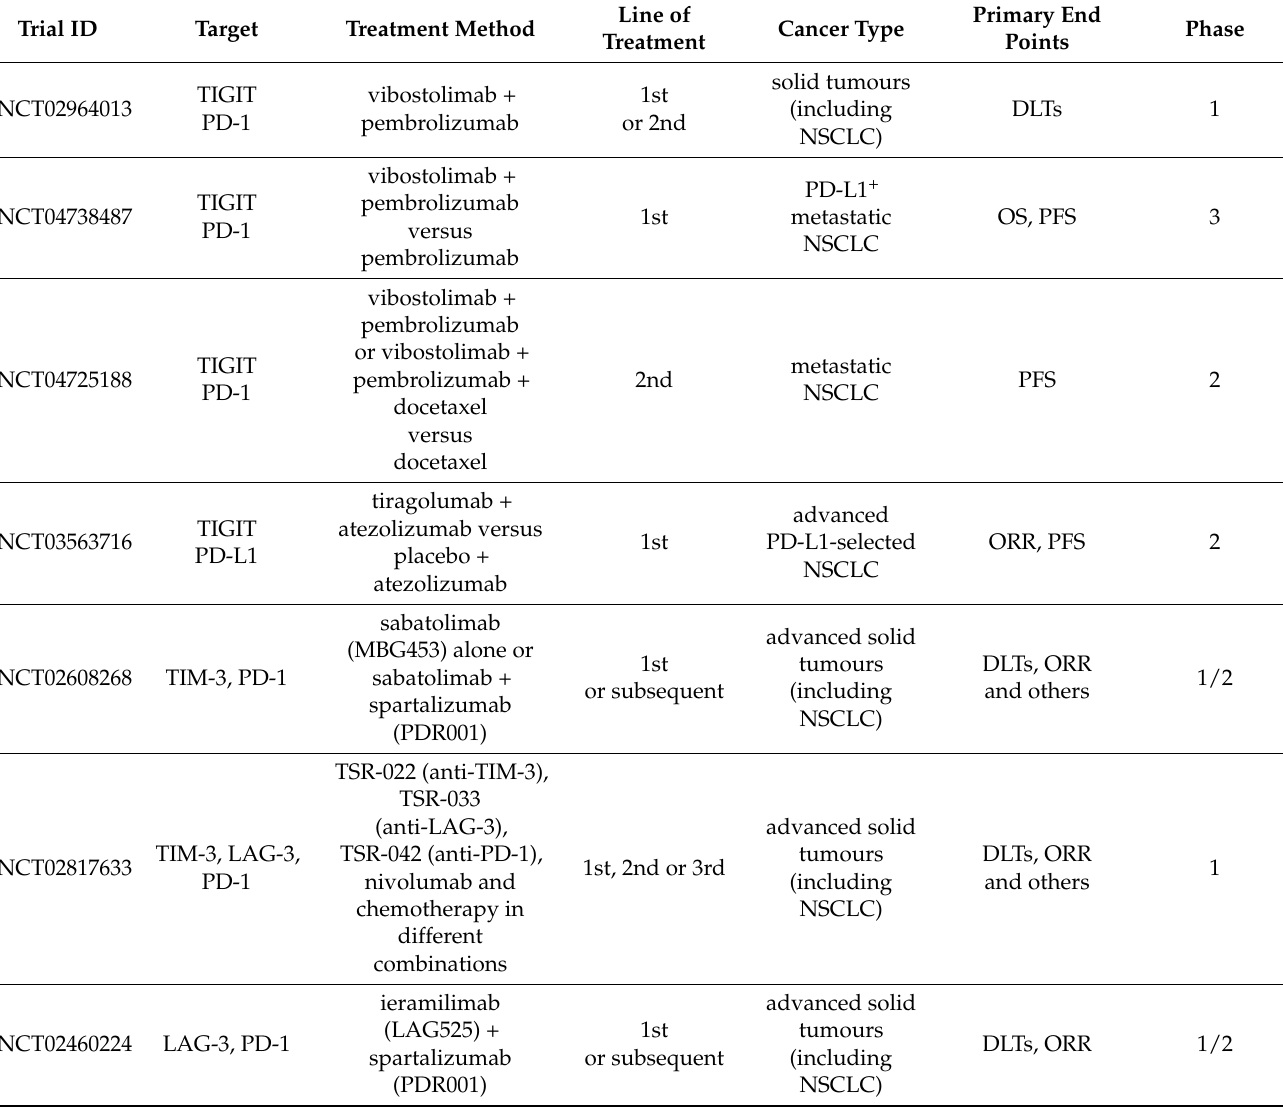
Table 2. Chosen clinical trials investigating antibodies targeting immune checkpoints in therapies of patients with solid tumours including